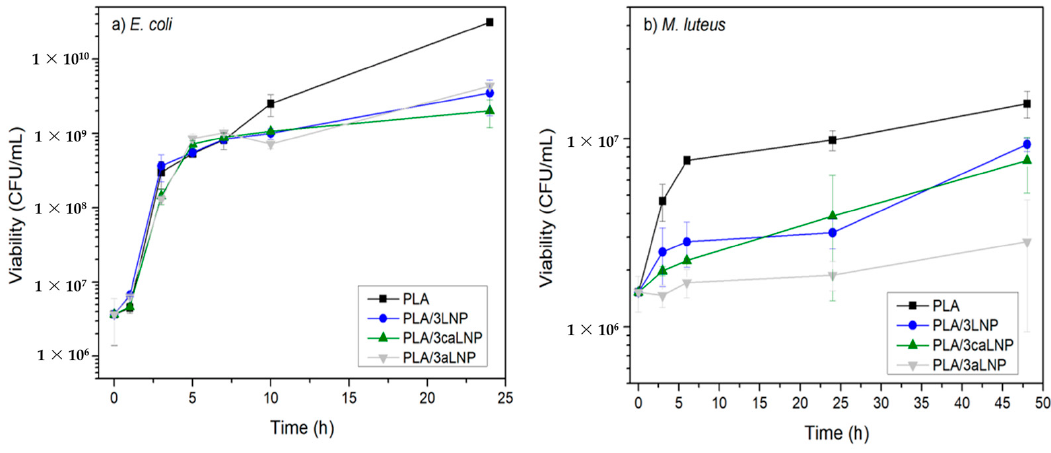
Figure 8. Antibacterial activity tests for PLA and PLA nanocomposite films containing 3 wt % of fillers: ( a ) against Escherichia coli and ( b ) against Micrococcus luteus .